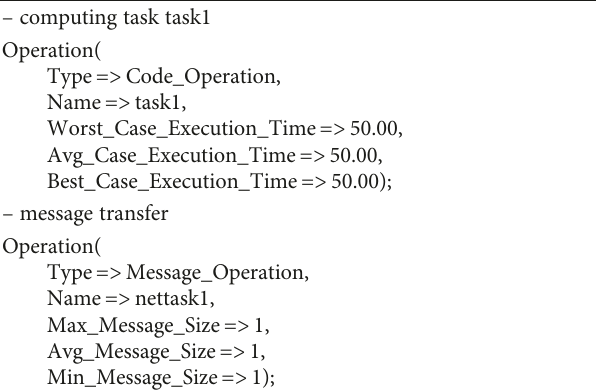
Table 10: Operation model element description.